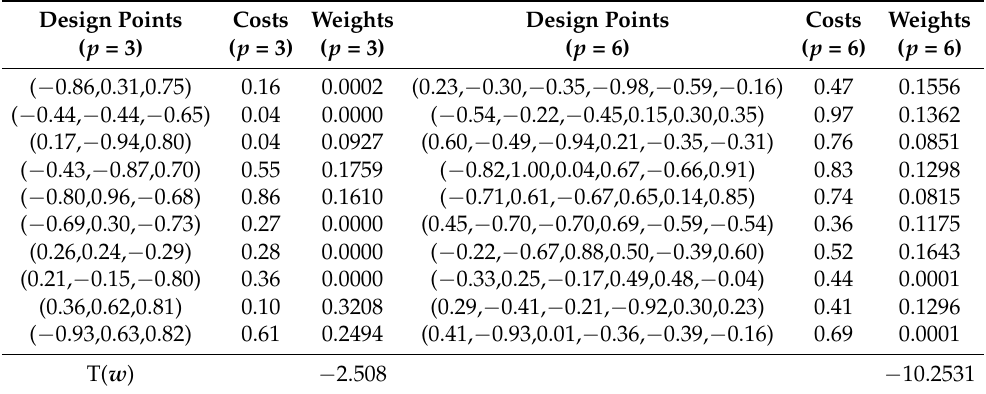
Table A2. Design points, costs, ED -optimal weights, and values of objective function (2) when k = 10. Design